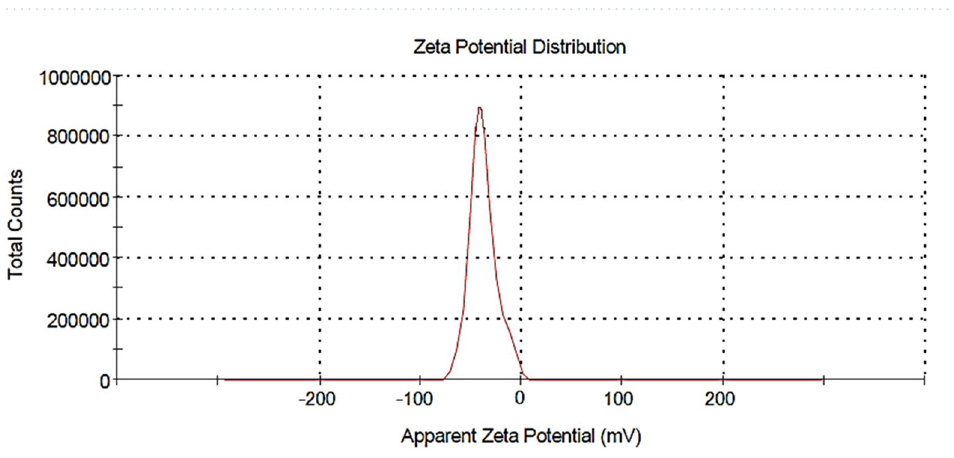
Figure 4. Zeta potential of synthesized